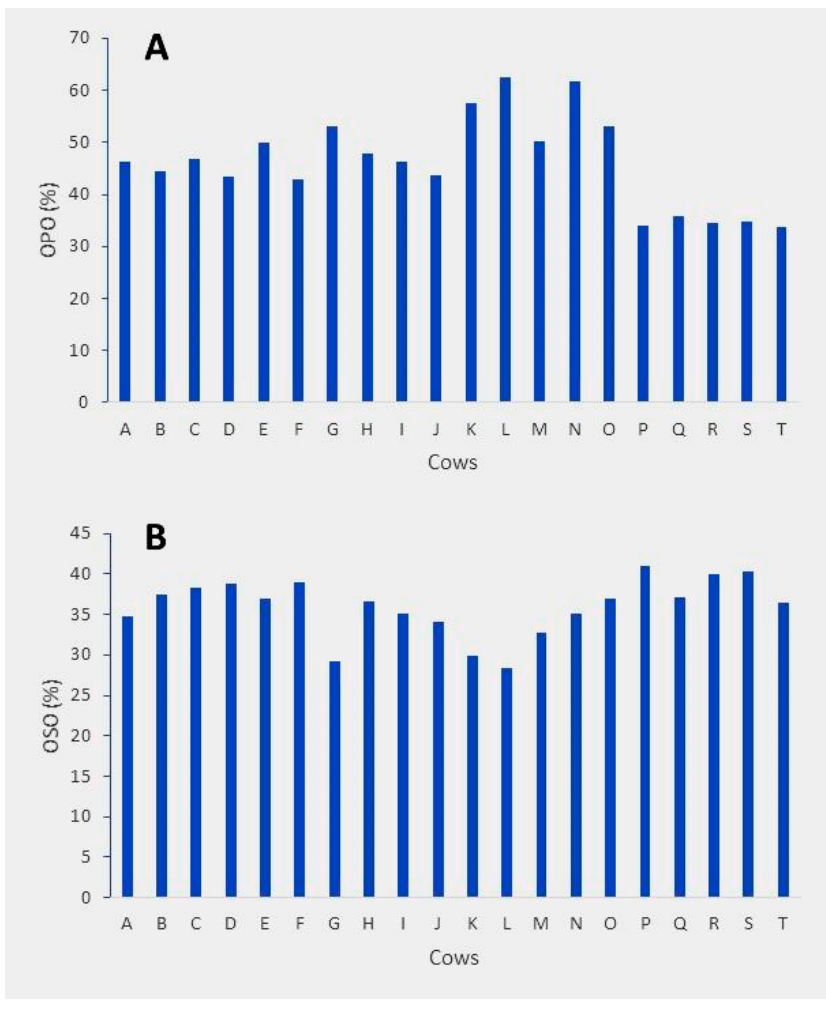
Figure 6. Variation of regioisomer OPO % ( A ) and OSO % ( B ) across the 20 milk samples of Holstein cows.